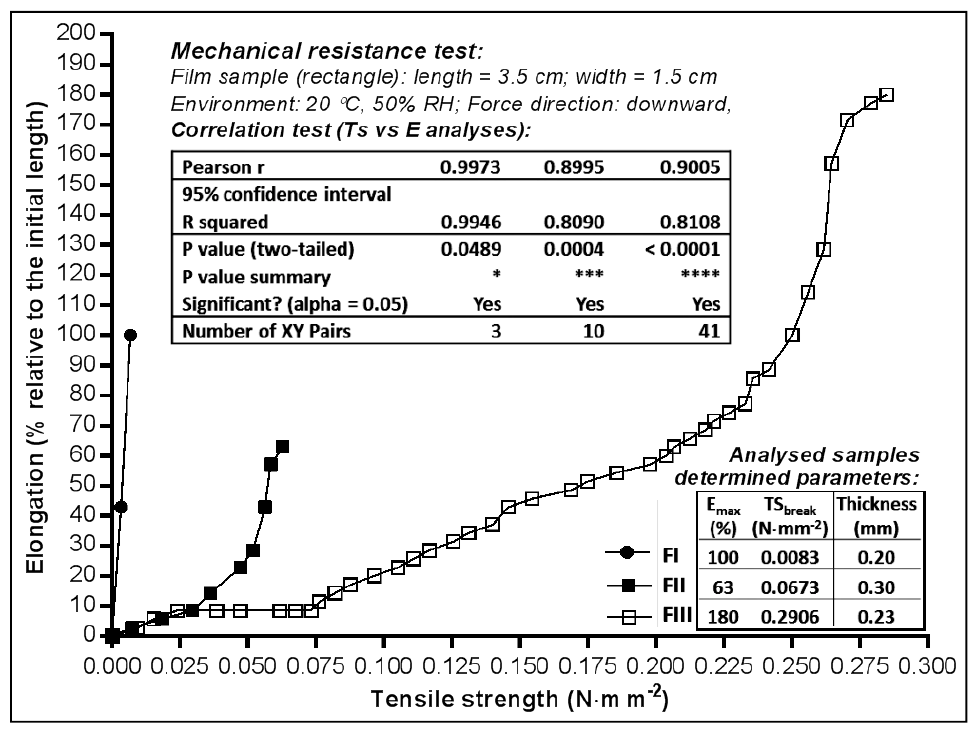
Figure 1. Elongation of dermal films as function of tensile strength.